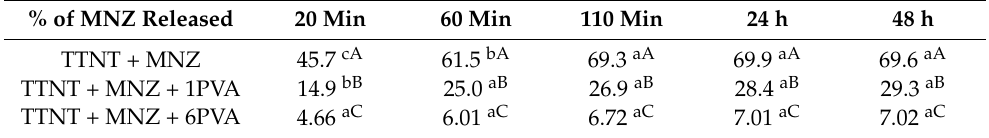
Figure 6. Cumulative release of MNZ with time: ( a ) whole experiment (14 days); ( b ) first 110 min. Table 2. Percentage of MNZ released in each measurement during the assay and statistical difference (different upper-case letters within a column indicate significant differences among experimental groups, different lowercase letters within a row indicate significant differences among time).